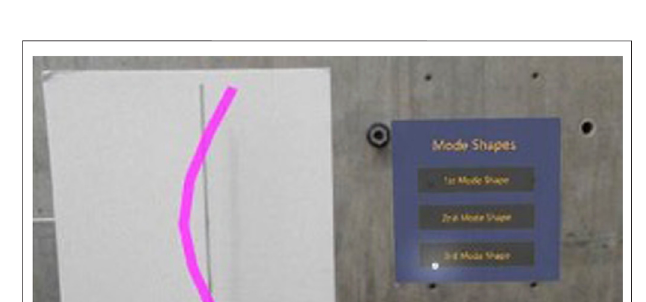
FIGURE 8 | Assisting workers with AR technology.